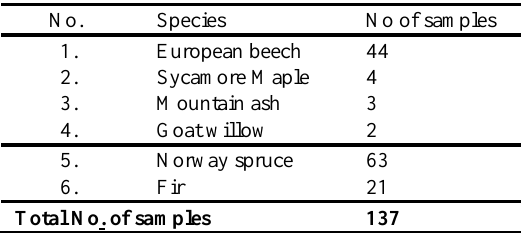
Table 1. Distribution of collected samples, by